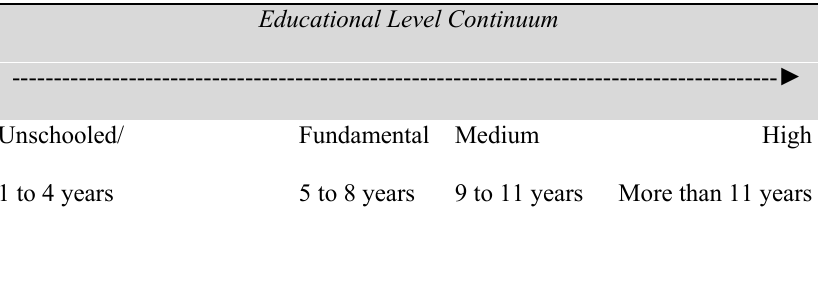
Figure 5. Education Level Continuum according to Brandão